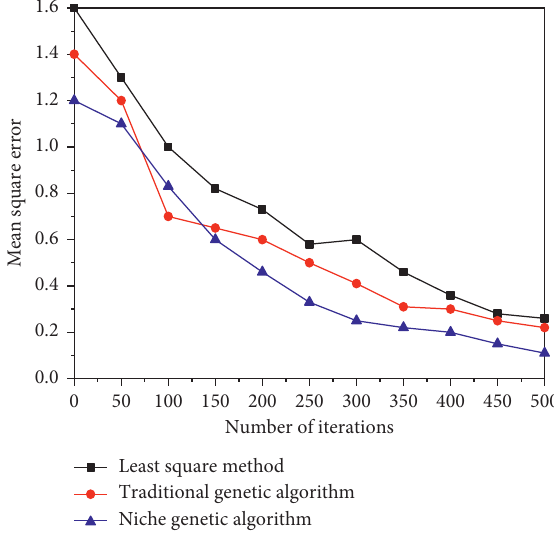
Figure 4: Contrast of algorithm